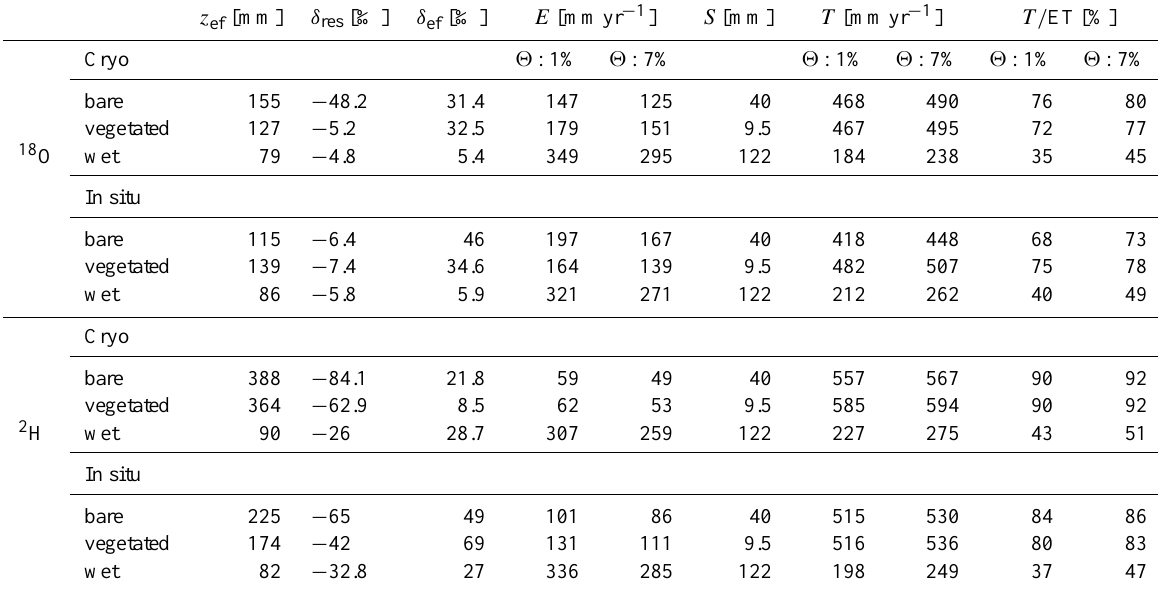
Table 3. Soil evaporation ( E ) is derived from stable isotope depth profiles. The isotope value of the reservoir δ res , the evaporating front δ ef , and the effective depth z ef are estimated from an exponential fit to the isotope depth profiles. The soil water storage ( S ) is calculated from the soil moisture depth profile. Transpiration ( T ) is the remainder from annual precipitation ( P = 660mm) after subtracting the recharge ( R = 4 and 5mm for 2 H and 18 O, respectively), E , and S . The partitioning between soil evaporation to transpiration is calculated as the contribution of transpiration ( T/ ET) to evapotranspiration (ET) for a range of soil moisture conditions (cid:50)